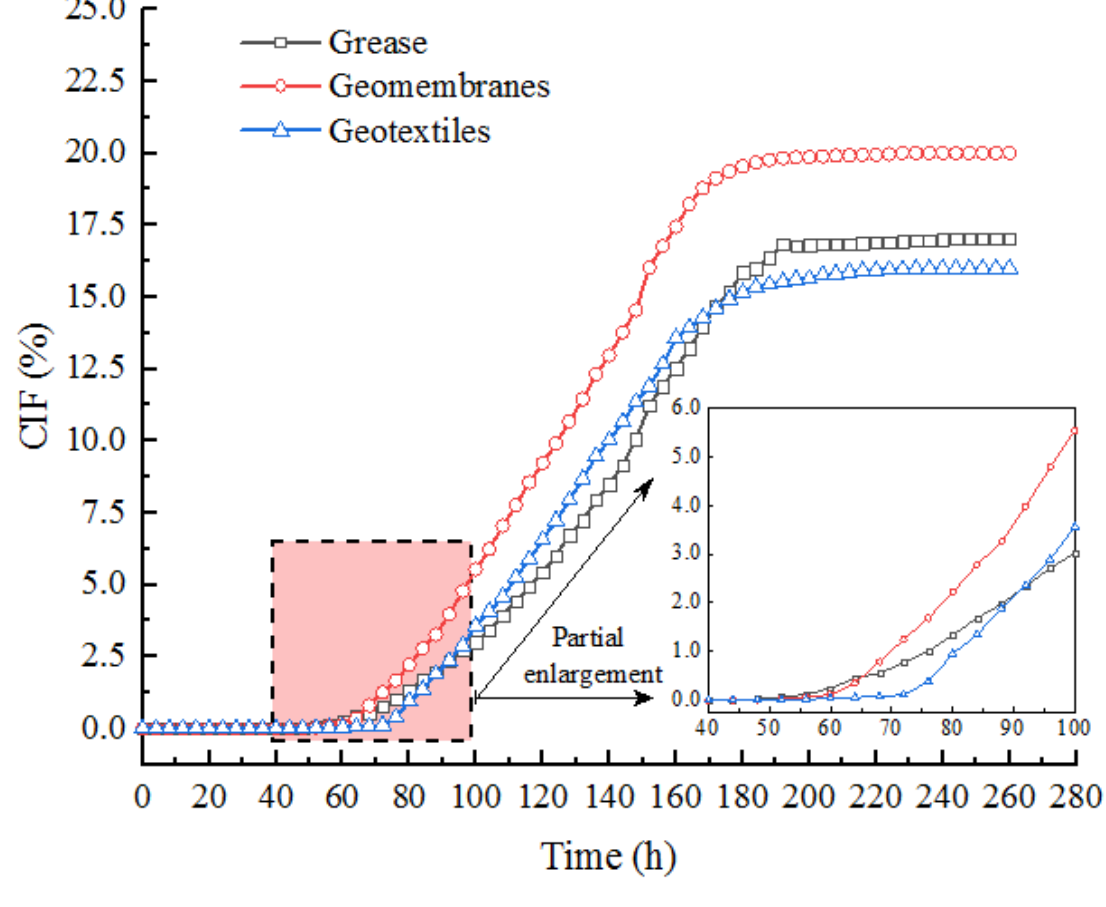
Figure 4. Crack intensity factor of soil samples with grease, geomembranes, and geotextiles versus time.